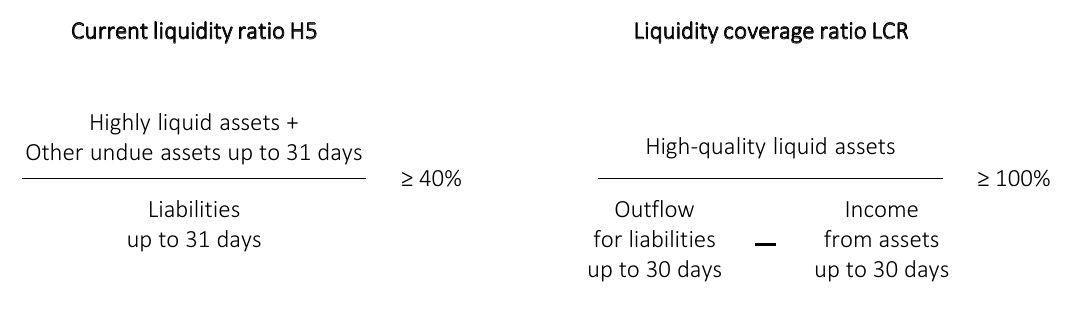
Figure 1. Comparison of current liquidity ratio Н5 and liquidity coverage ratio